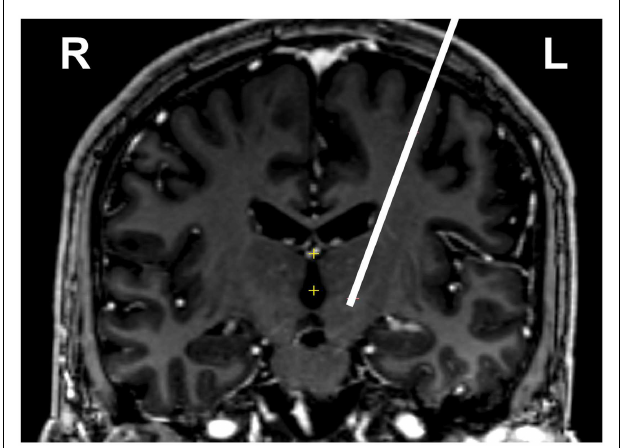
FIGURE 1 | Preoperative image guided targeting of left STN for one subject .White line is the trajectory, shown on top of a coronal section at level of target, at bottom of line (actual tract is paracoronal). Image isT1 contrast weighted, neurological conventions where left is on image